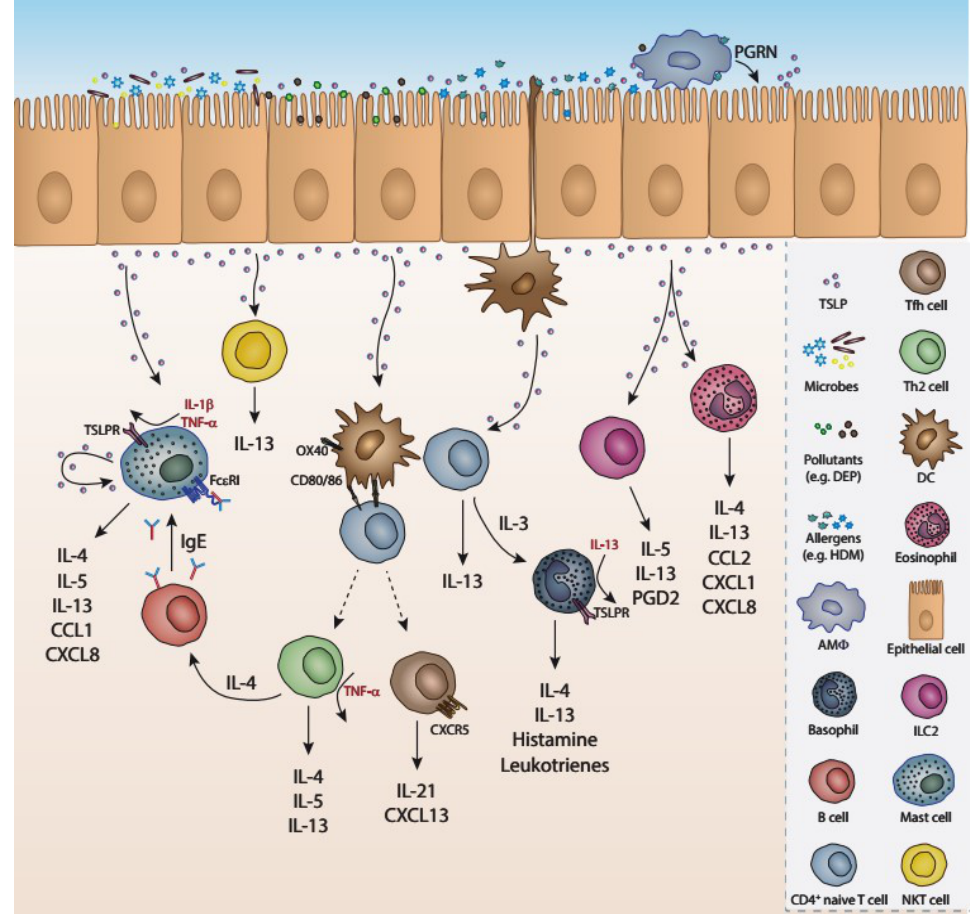
Figure 2. Cellular sources and targets of TSLP. Several stimuli including microbes, pollutants, allergens, proteases and cytokines such as IL-4, IL-5, IL-13, and the macrophage-derived progranulin trigger the production of TSLP from the epithelium. TSLP acts on a variety of cells, including DCs, ILCs CD4 T cells mast cells basophils, etc., and upregulates the expression of co-stimulatory molecules (CD80, CD86, OX40). It also induces the secretion of a plethora of cytokines (IL-4, IL-5, IL-13) and chemokines (CCL1, CXCL8, CXCL1, CXCL13), further amplifying the asthmatic responses.